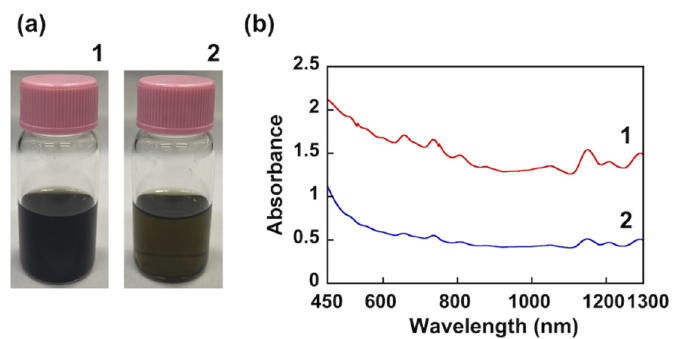
Figure 3. ( a ) Photographs of suspensions in THF. ( b ) Absorption spectra of suspensions in THF. ( 1 ) PC 56 T 44 /SWCNT composite (1:1 ( w/w )), ( 2 ) PT/SWCNT composite (1:1 ( w/w )).